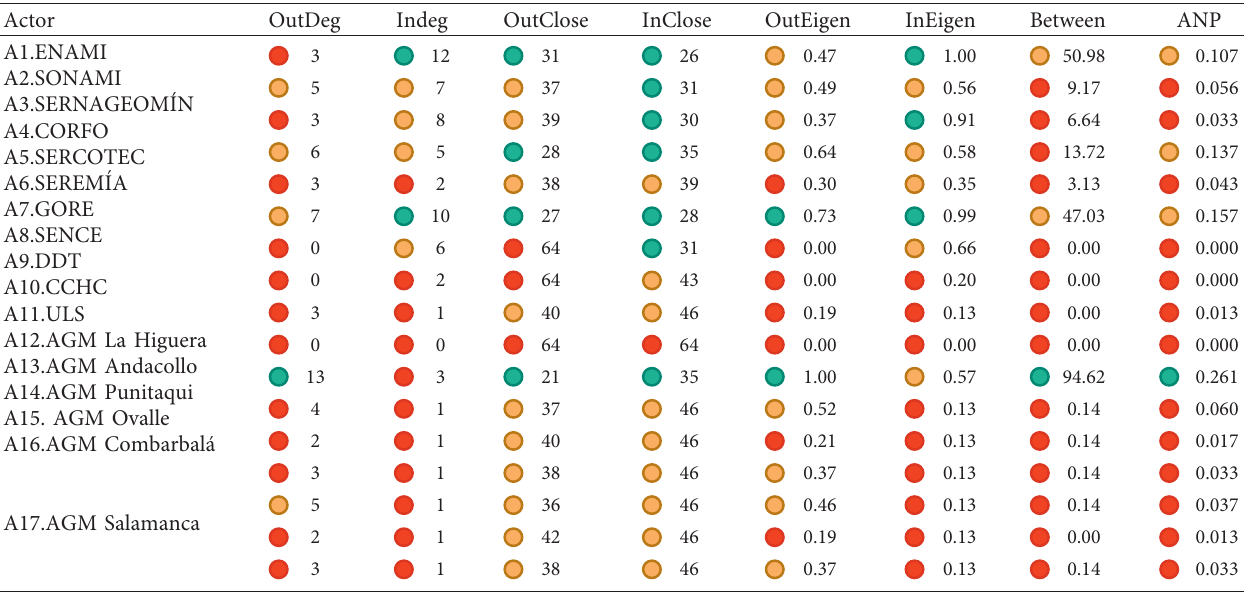
Table 6: The SNA-ANP